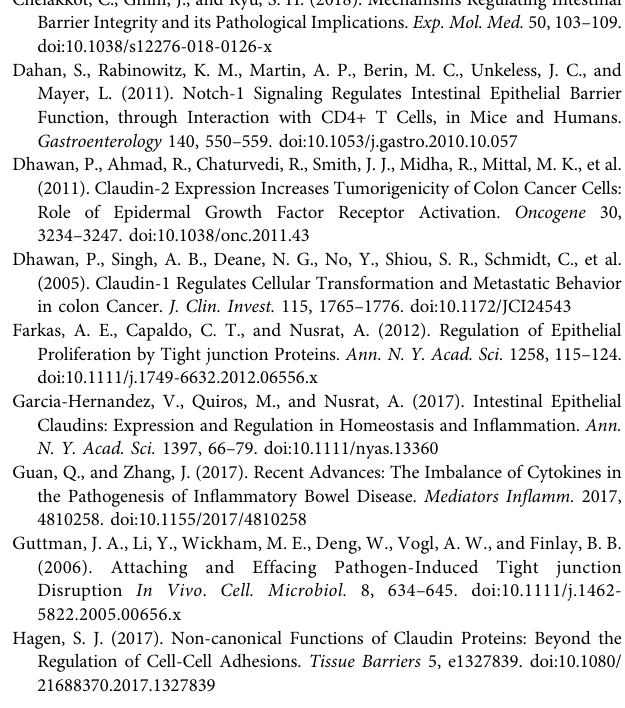
Supplementary Figure S1 | Negative control for immunohistochemistry: tissue stained without primary antibody. (A) R&D System Kit CTS002, control mouse tissue; (B) R&D System Kit CTS005, control mouse tissue; (C) R&D System Kit CTS008, control mouse tissue; (D) DAKO EnVision System Detection Kit, Human control tissue Supplementary Figure S2 | Gating strategy for fl ow cytometry analysis. Time vs. forward scatter-height (FSC-H) was used to check the quality of the sample acquire followed by exclusion of doublets on FSC-H vs FSC- Width (FSC-W) and FSC-H vs FSC-Area (FSC-A). Side scatter-area (SSC-A) vs red-FL3-A APC-Cy7 CD45 was done to gate CD45 + leukocytes. From live CD45 + leukocytes gate B and T lymphocytes were gated followed by a gate from double-negative population (CD20 − CD3 − ) was used for gating HLA-DR + CD14 + monocytes/macrophages cells. Each claudin (claudin-1, claudin-2, claudin-3, and claudin-4) was gated on histogram plots for each cell type population. Fluorescence-minus-one (FMO) controls were used for setting the gates. Supplementary Figure S3 | Claudin-1, claudin-4, and claudin-8 expression in absorptive/secretoryepithelialcellsandclaudin-3expressionwithinlymphoidfollicle in control human colon tissue. (A) Claudin-1 (IHC), control, tuft cells; (B) claudin-1 (IHC), control, goblet cells; (C) claudin-1 (IHC), control, goblet cells; (D) claudin-4 (IHC), control, absorptive cells; (E) claudin-8 (IHC), control, absorptive cells; (F) claudin-8 (IHC), control, goblet cells; (G) claudin-3 (IHC), control, epithelium, and lymphoid follicle; (H) claudin-3 (IHC), control, germinal center; (I) claudin-3 (IHC), control, HEV. Supplementary Table S1 | Criteria for histological evaluation of disease activity in IBDandanimalmodelsofIBD. (A) HistologicscorefordiseaseactivityinIBDpatients modi fi edfromthemethodpublishedbyNainiandCortina(2012) (B) Histologicscore for disease activity in DSS animal model published by Nishitani et al. (2009) (C) Histologic score method for disease activity in adoptive transfer animal model published by Laroux et al.